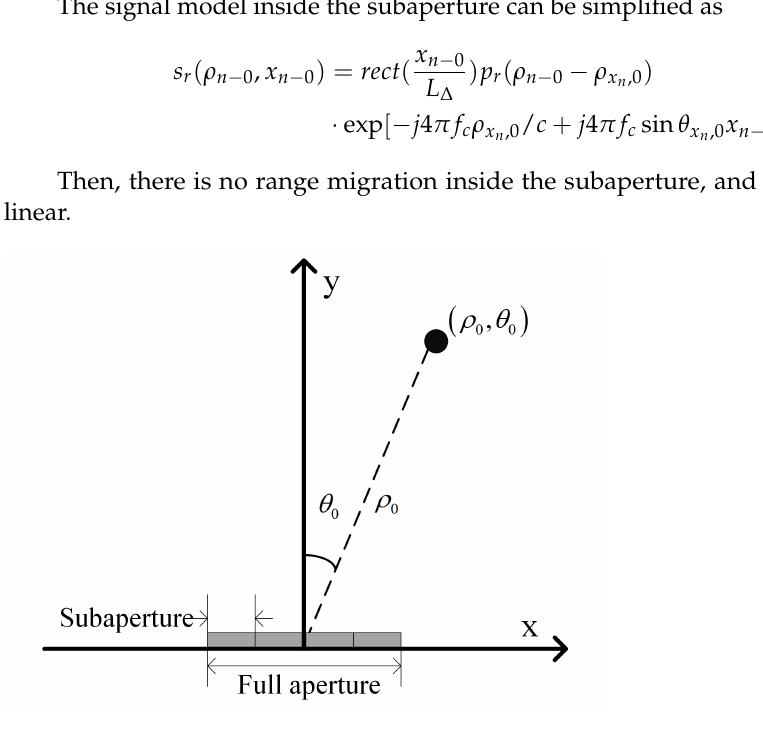
Figure 11. Subaperture geometric model of ground-based